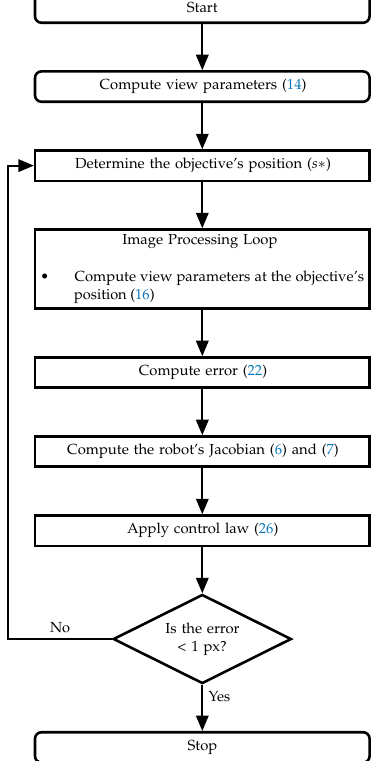
Figure 5. Control